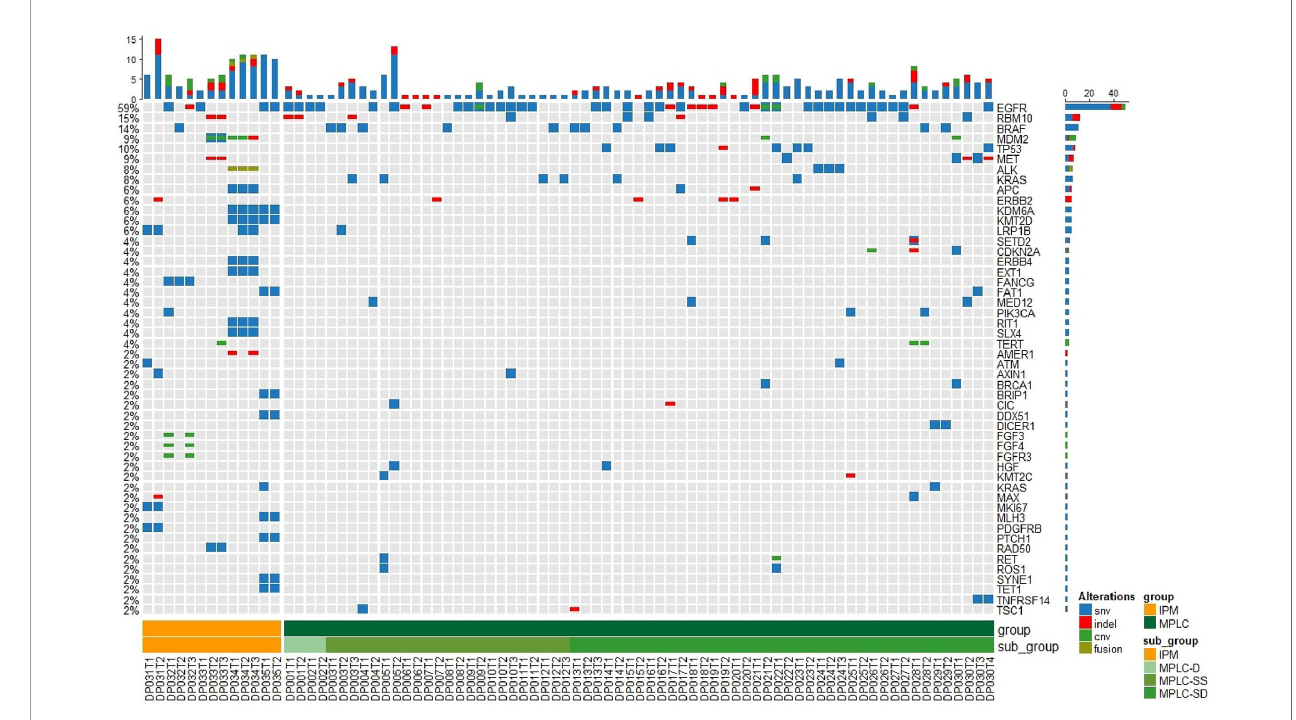
FIGURE 1 | The mutational landscape of all lesions from the training cohort, including 30 MPLC and 5 IPM patients. The top 50 mutated genes are shown as indicated. Different types of mutations are shown in different colors. MPLC-SD, lesions at the same lung but different lobes; MPLC-SS, lesions at the same lung and same lobe; MPLC-D, lesions at bilateral